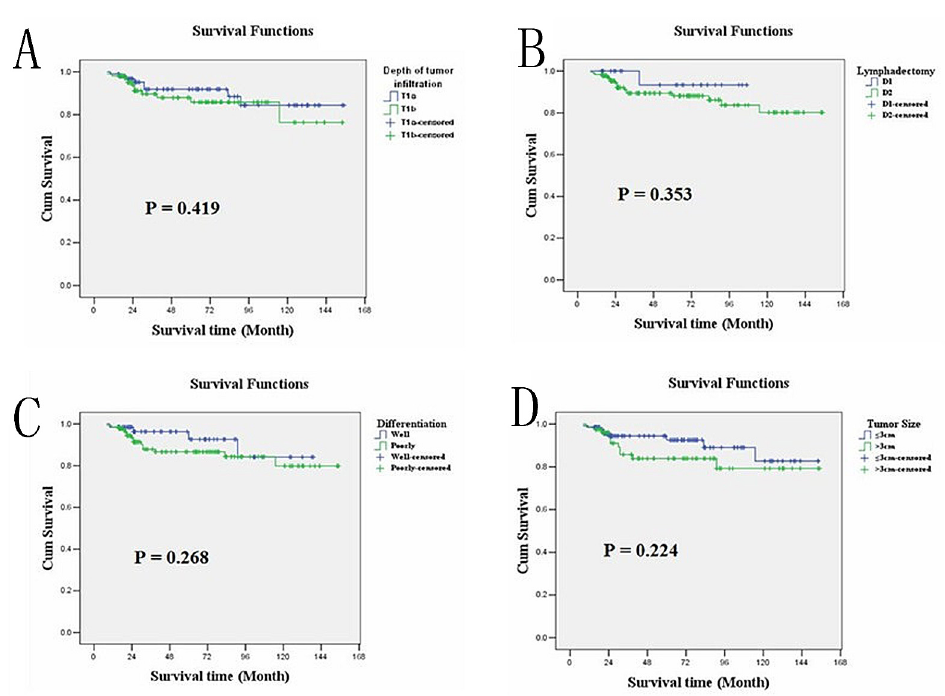
Fig 6. Kaplan-Meier survival analysis showed that overall survival of EGC was not correlated with (A) depth of tumor infiltration(P = 0.419), (B) D1 or D2 resection(P = 0.353), (C) cell differentiation (P = 0.268), (D)tumor size(P =